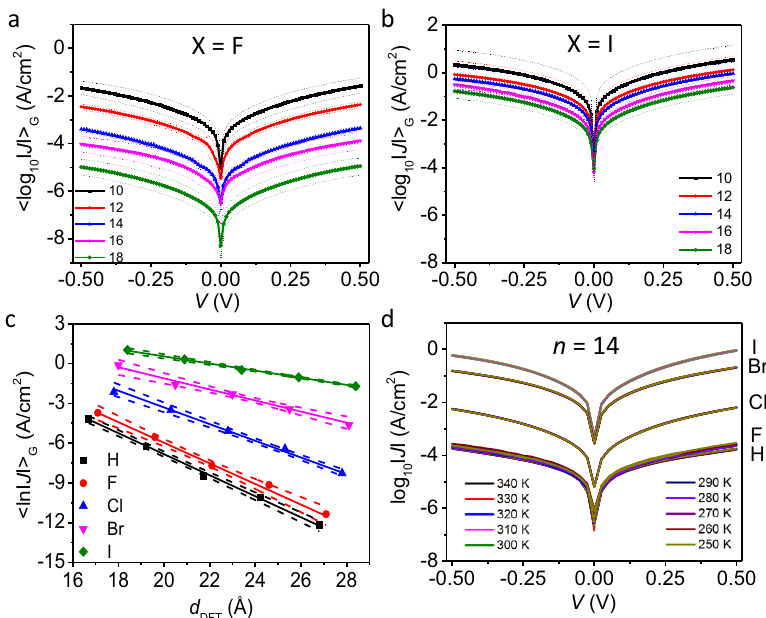
Fig. 3 Electrical characterization of junctions. Gaussian log-average values of the current densities <log 10 | J | > G vs. applied bias V obtained from Ag – S (CH 2 ) n X//GaO x /EGaIn junctions with X = F ( a ) or I ( b ) and n = 10 (solid black line), 12 (solid red line), 14 (solid blue line), 16 (solid pink line), and 18 (solid green line). The dashed-line error bars represent the Gaussian log-standard deviation, σ log,G . c Decay plots of <log 10 | J | > G at – 0.5 V against d SAM,MD with X = H (black square), F (red circle), Cl (blue triangle), Br (pink inverted triangle), or I (green diamond). The solid lines are fi ts to Eq. (1). The dashed lines represent the 95% con fi dence bands. d Plots of log 10 | J | vs. V as a function of T ( T = 250 – 340 K) recorded from Ag – S(CH 2 ) 14 X//GaO x /EGaIn shows the decay of <log 10 | J | > G at – 0.5 V as a function of d SAM,MD (Supplementary Section 5 and Supplementary Table 1) for all X.